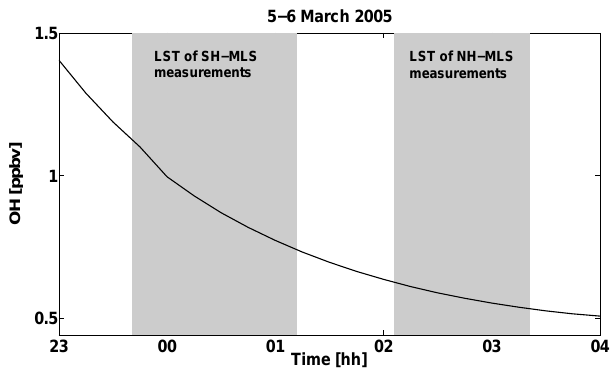
Fig. 3. OH mixing ratio from SIC model simulations for 5–6 March, 2005 at 60 ◦ N and 0 ◦ E and averaged between 70 and 78km. Ap- proximate LST times of MLS measurements for NH and SH are indicated by grey